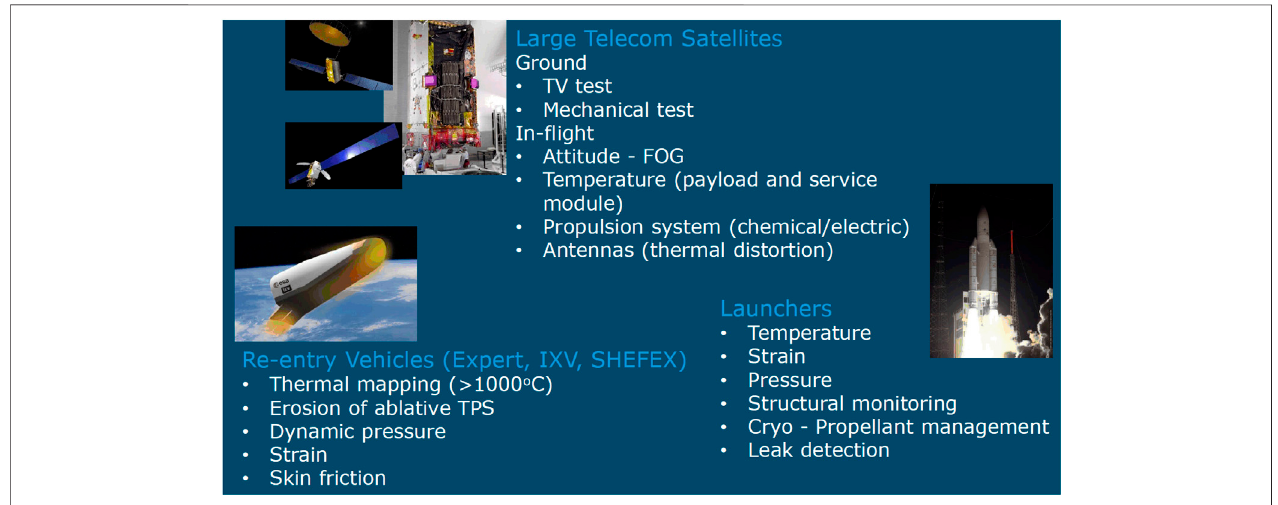
FIGURE 1 | Schematic overview of spacecraft